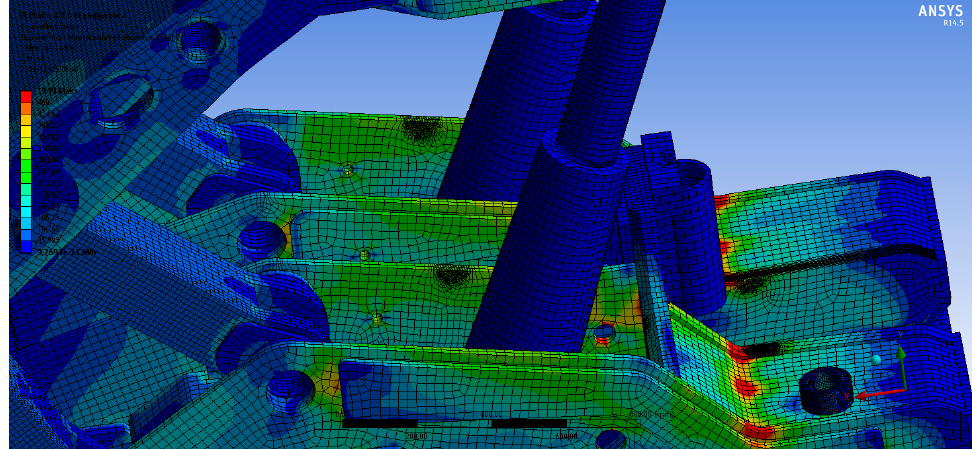
Figure 8. Stress analysis on a finite element grid—support’s canopy.